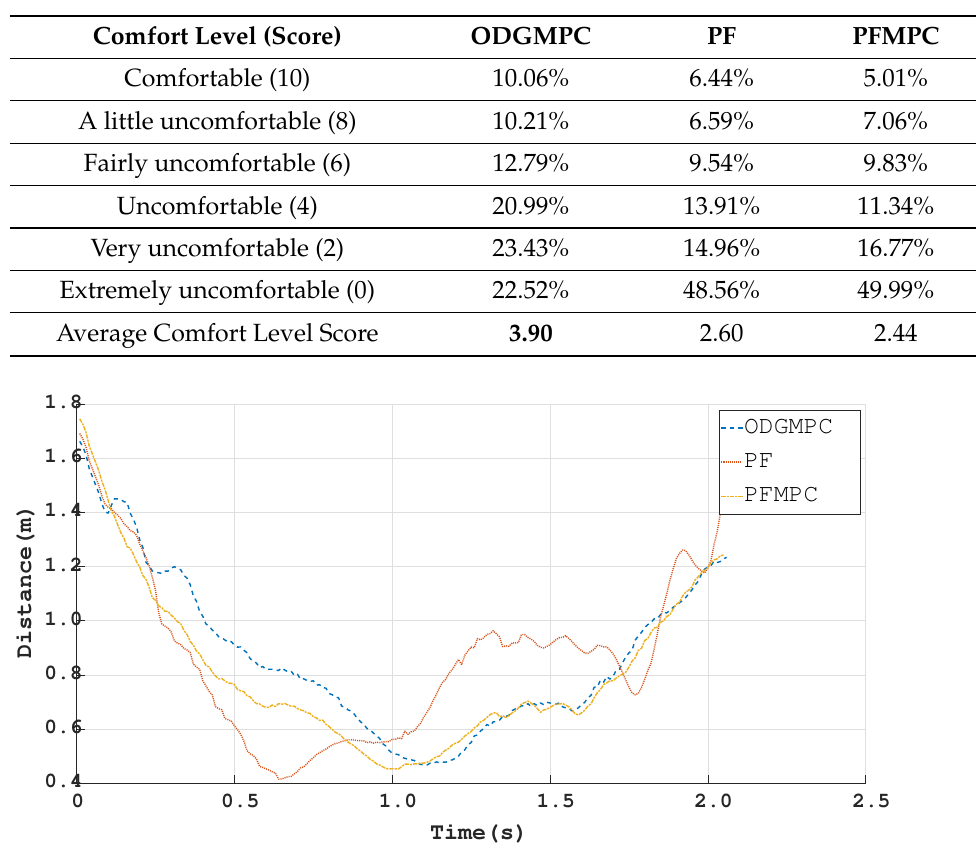
Table 12. Average result scores for 10 experiments with one dynamic and one static obstacle.